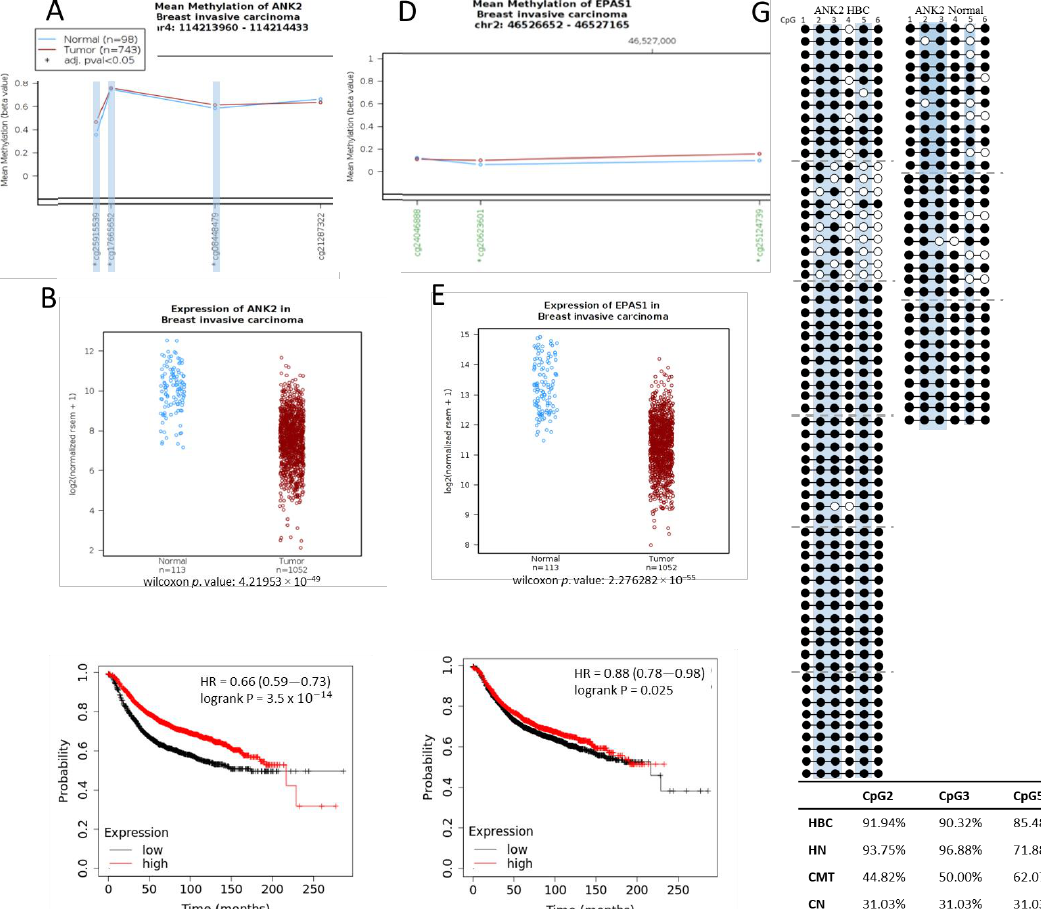
Figure 5. Hypermethylation of orthologous human target ANK2 and EPAS1 regions. Mean Methylation (beta value) plots for orthologous human ( A ) ANK2 and ( D ) EPAS1 regions for normal (blue) and invasive breast cancer patient(red) data obtained from TCGA. Specific methylation probes, annotated at the bottom of the graph are indicated to be in a CpG island when written in green ( only seen for EPAS1 ), and designated as significant (*) with an adjusted p -value < 0.05. Three significantly hypermethylated CpGs from ANK2 are highlighted in light blue to indicate that they are conserved in the dog genome. ( B ) ANK2 and ( E ) EPAS1 log2 (normalized rsem +1) expression data from TCGA for normal (blue) and invasive breast cancer patients (red). Wilcoxon p-values are indicated. ( C ) ANK2 and ( F ) EPAS1 Kaplan-Meier plots indicting relapse-free survival with high and low expressions each. ( G ) ANK2 sequencing results for cfDNA from normal and HBC patients. Between 10 and 11 colonies were sequenced for 6 individual HBC cfDNA samples (separated by grey dotted lines) and between 10 and 12 colonies were sequenced from 3 separate normal cfDNA samples. Methylation of a specific CpG is indicated by a black circle and non-methylation by a white circle. The CpGs at positions 2, 3, and 5 are highlighted in light blue as these are the CpGs that correlate with the hypermethylated CpG probes indicated in ( A ) and the respective percentage methylation for these CpGs in the HBC and normal human (HN) cfDNA samples, as well as in canine CMT and normal (CN) tissue (Figure 2A), are indicated in the inserted table.